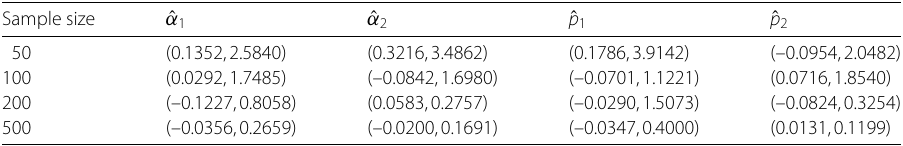
Table 2 Bias and SE of the parameters in Models I with λ = 2